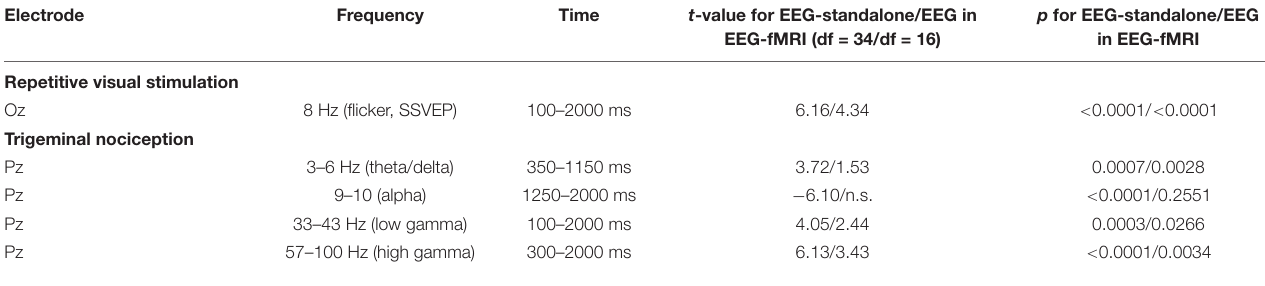
TABLE 1 | Time-frequency windows of interest derived from the study by Bader (2019) and Mehnert et al. (2019).